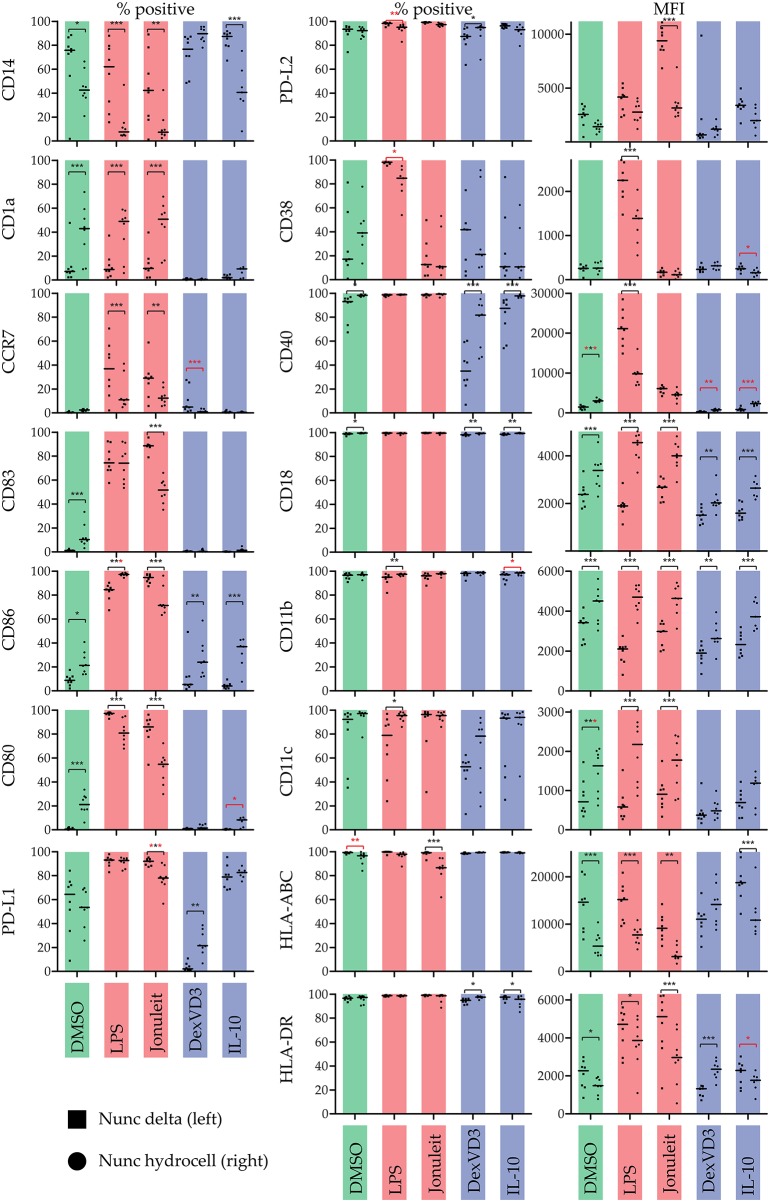
Influence of the culture dish on the phenotype of differentially stimulated moDC. The phenotype was analyzed by flow cytometry using the indicated surface molecules. % positive cells or median fluorescence intensity (MFI) are shown. Color code: Control (DMSO)—green, immunogenic DC populations (LPS & Jonuleit cytokine cocktail)—red, tolerogenic DC populations (Dexamethasone with vitamin D3 & IL-10)—blue. Squares (left): standard culture dish; circles (right): non-adherent culture dish. The median is marked with a line. Significance values are given in grades *P < 0.05, **P < 0.01, and ***P < 0.001. Black significance grades are the result of a collective 2 way ANOVA testing for all treatments, red grades are from separate tests for the iDC/tolDC and immunogen subgroups (n = 8).